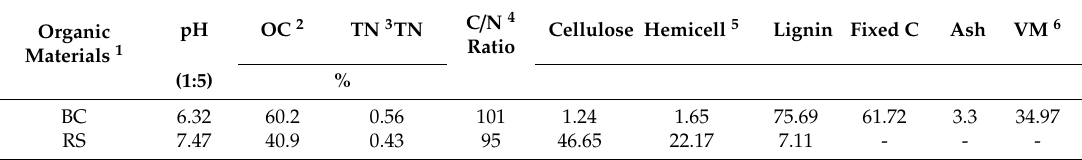
Table 1. Characteristics of the BC and RS used in the experiments.